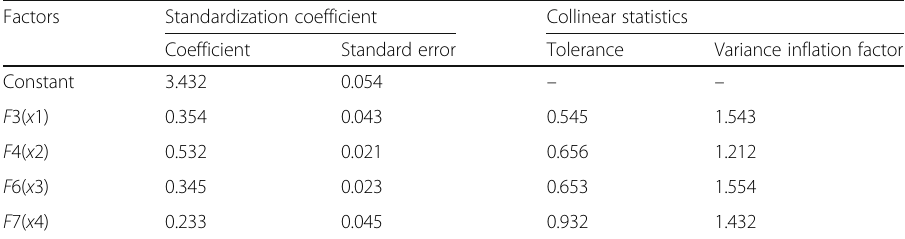
Table 5 Regression model coefficient table for performance evaluation Factors